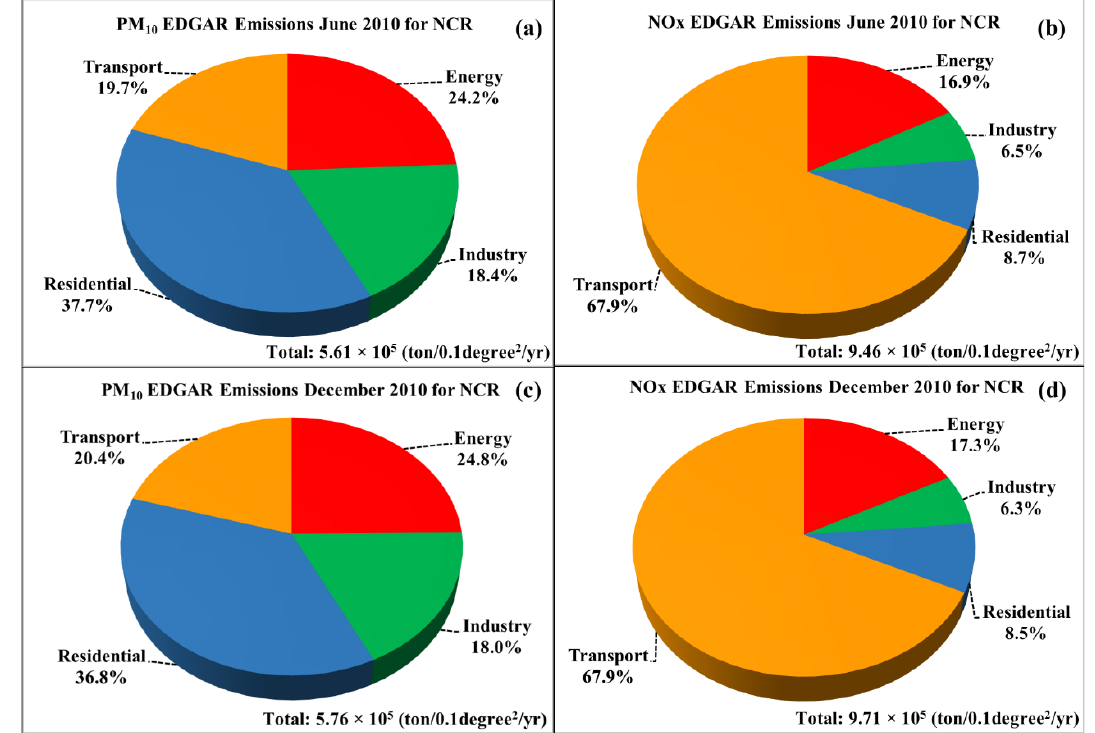
Figure 1. Contribution of different sectors to PM 10 ( a , c ) and NOx ( b , d ) EDGAR emissions over NCR in June 2010 (upper panel) and December 2010 (lower panel) at 0.1° × 0.1° resolution (EDGAR emission inventory).